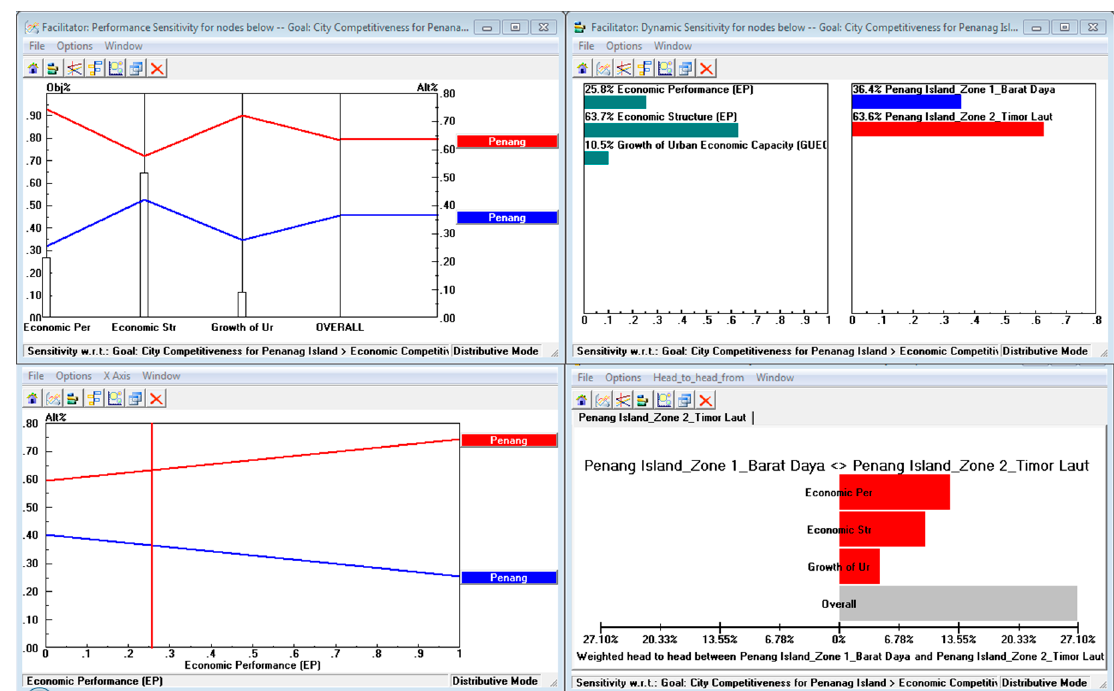
Figure 6. Dynamic, gradient, head-to-head, 2D-sensitive analysis chart of economic subcriteria and alternatives in the Expert Choice score.